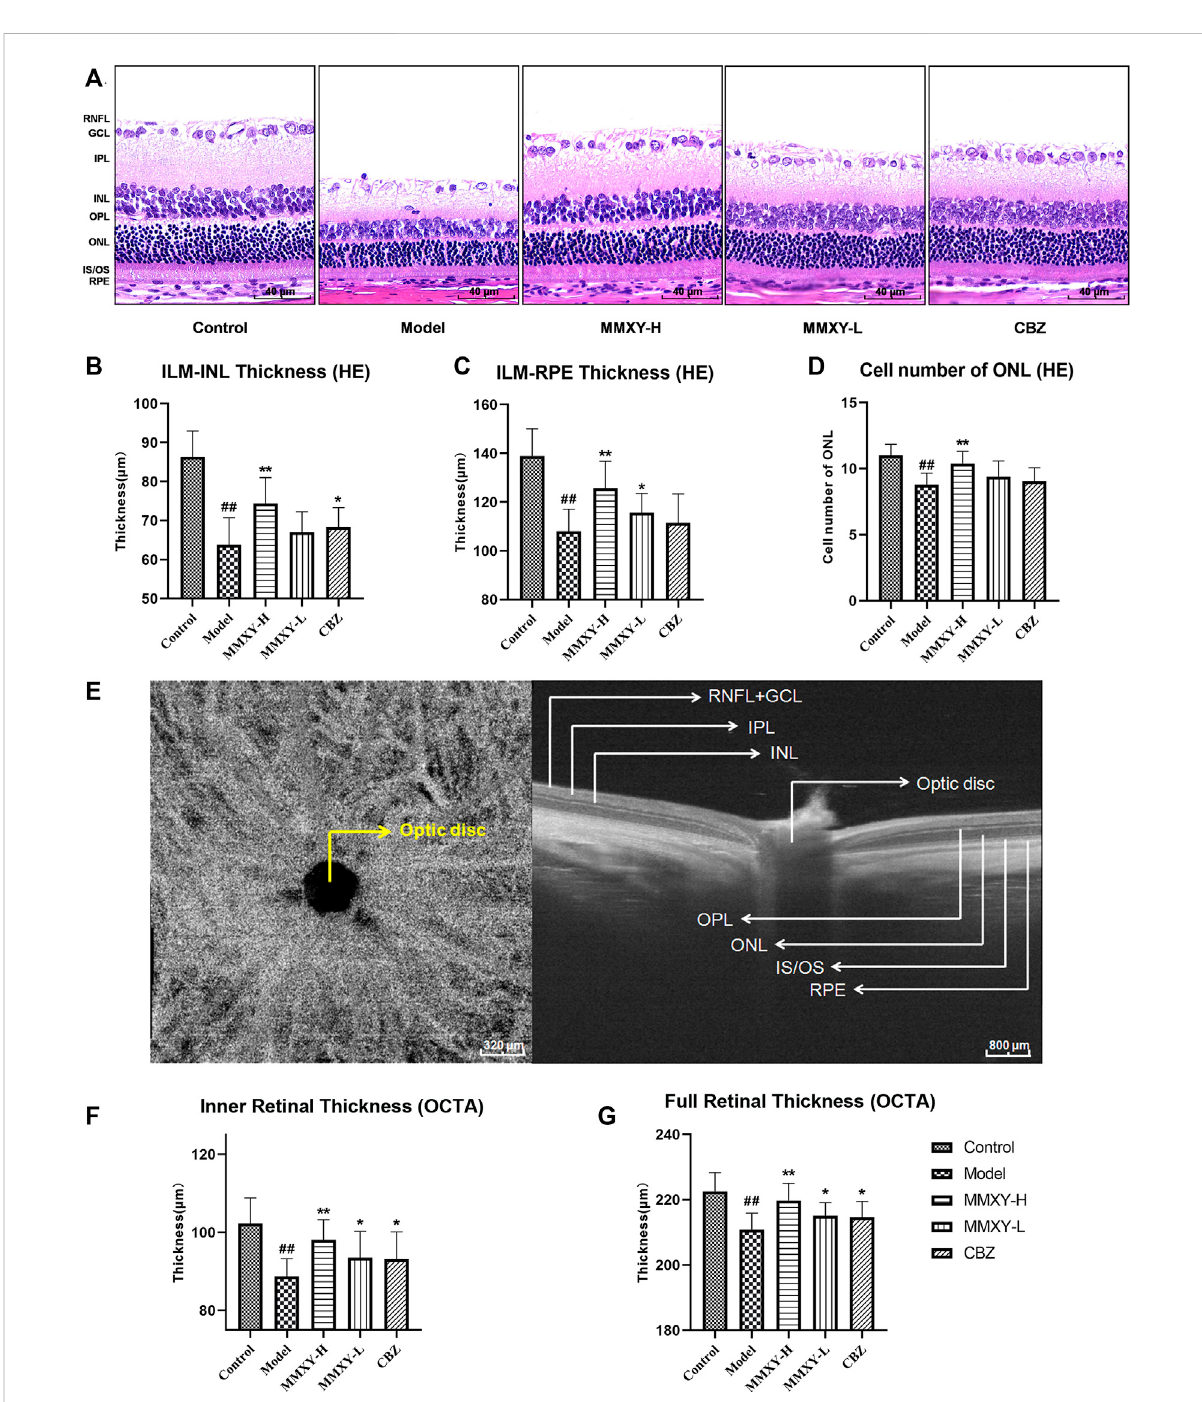
FIGURE 5 Effects of MMXY on morphology and thickness of the retina in CUMS rats. (A) HE staining morphology and thickness of retina in each group.Scalebars=40um. (B,C) ThethicknessofILM-INLandILM-RPEinHEstaining(n=18points). (D) HEstainingshowedthenumberofONLcells in each group (n = 18 points). Results are shown as the mean ± SD. # p < 0.05 and ## p < 0.01 vs. control group; * p < 0.05 and ** p < 0.01 vs. model group. (E) B-scanimageofratretinainOCTA.Scalebars=320/800 µm. (F,G) OCTAresultsoftheinnerandfullthicknessofretinaineachgroup (n = 16 eyes). Results are shown as the mean ± SD. # p < 0.05 and ## p < 0.01 vs. control group; * p < 0.05 and ** p < 0.01 vs. model